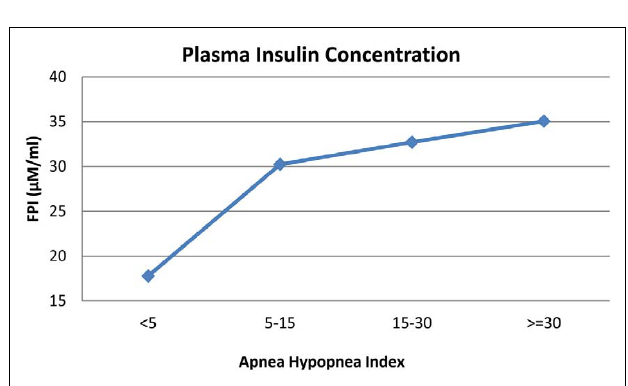
FIGURE 9 | Correlation between plasma insulin and severity of